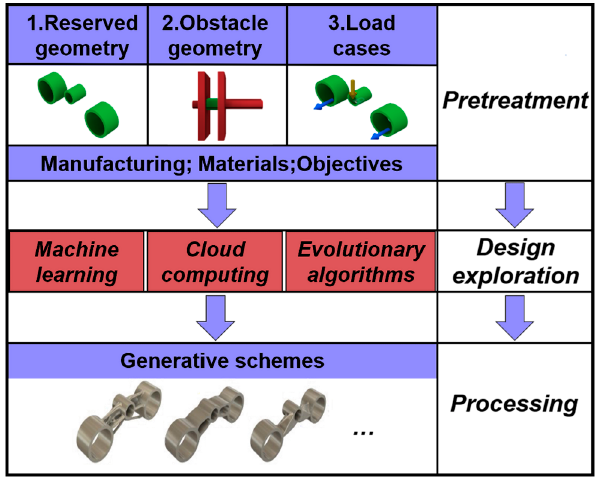
Figure 2. The process of generative